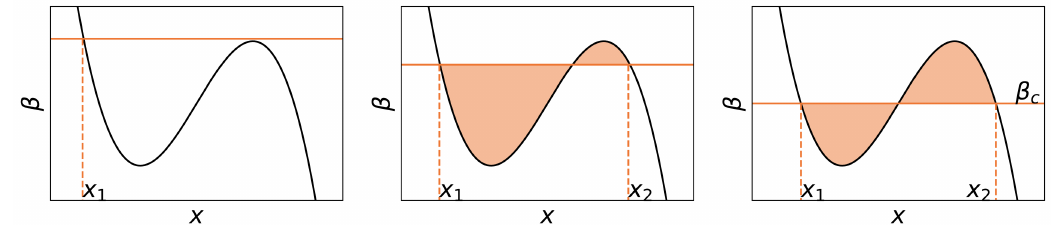
Figure 5 . Schematic representation of possible choices for β c , x 1 and x 2 satisfying the condi- tions (3.2) and (3.3). The black line is a sketch of the first derivative of the entropy near a first order phase transition and the horizontal orange line is β . The shaded region is the integral in (3.2). Outside the critical region (left), there is only one solution for (3.3). When we approach the phase transition (middle, right) there are 3 solutions for (3.3). We illustrate in the middle panel a choice of x 1 and x 2 for which for which condition (3.2) is not satisfied. Actually, only the choice of β , x 1 and x 2 shown on the right panel satisfies both conditions. This uniquely defines β c . The latent heat is then obtained as x 2 − x 1 . Physically, this implies that when β crosses β c , we observe a discontinuity in the action of magnitude x 2 − x 1